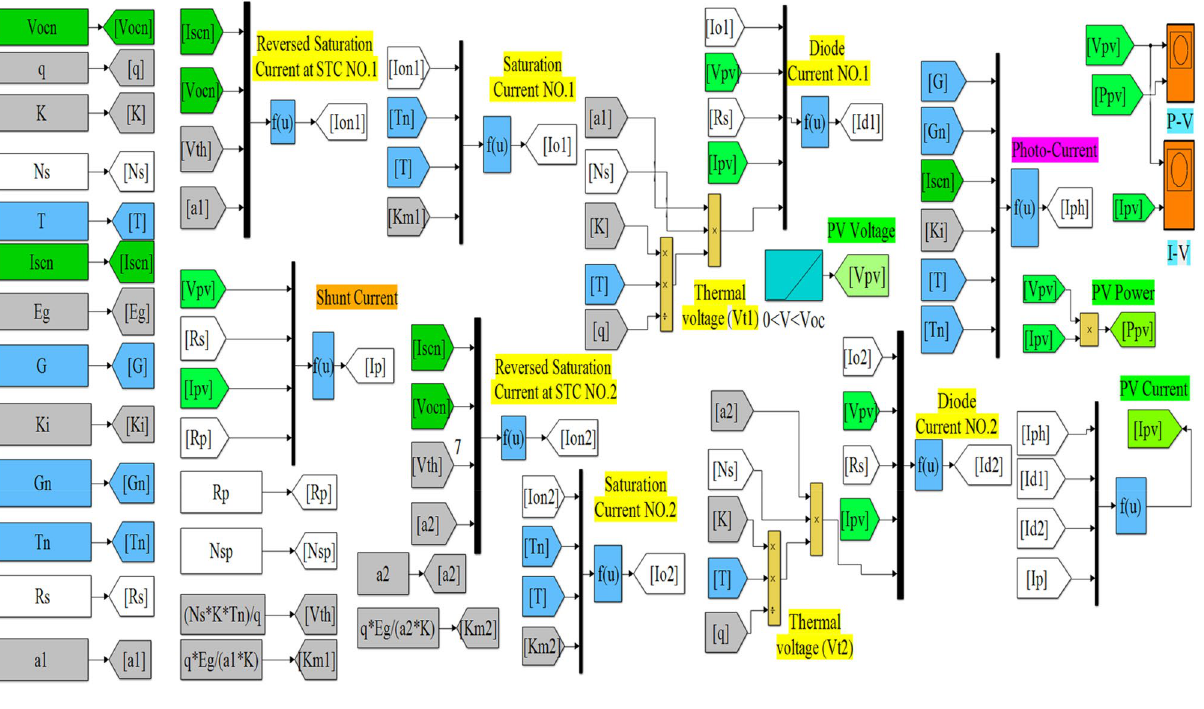
Figure 6. Double-diode model in Matlab.